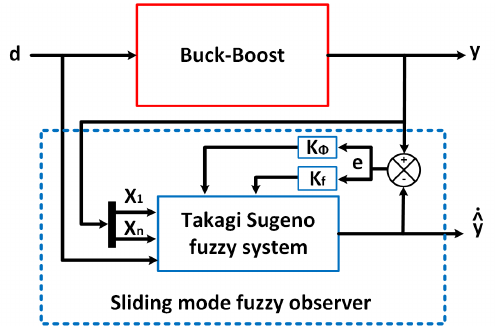
Figure 12. DC-DC converter fuzzy